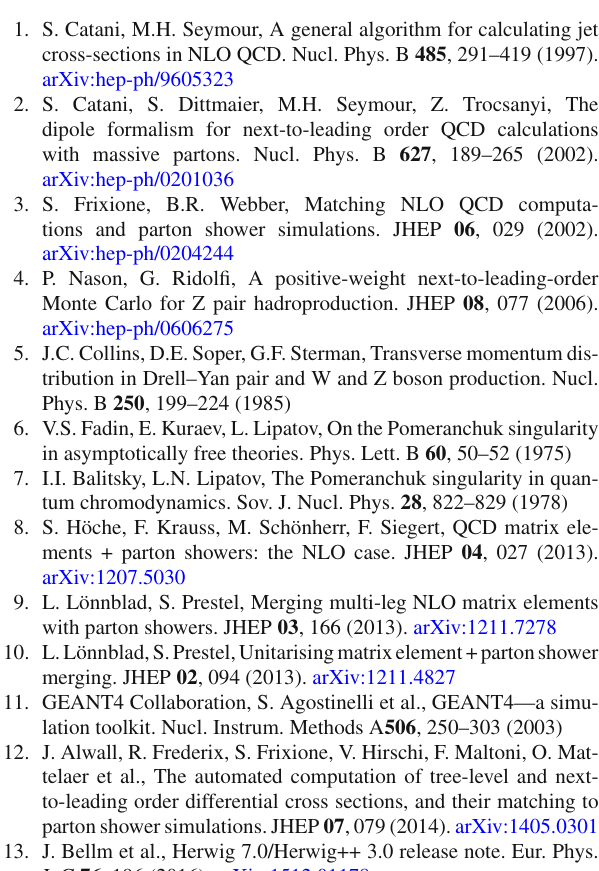
3. Choose the negative-weight event with weight closest to zero (“least